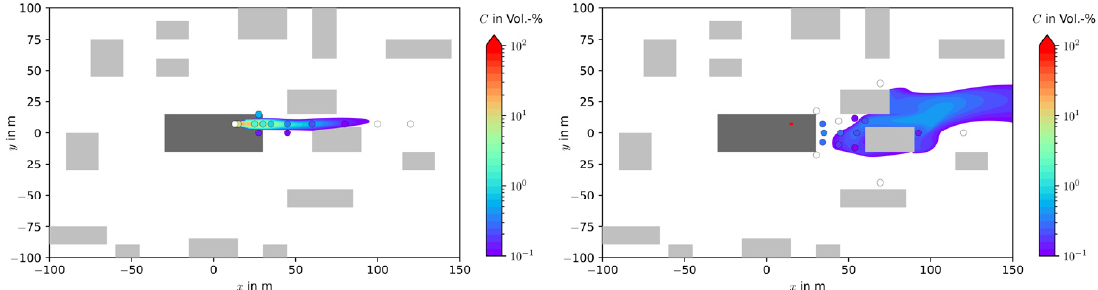
Figure 14. Heavy gas dispersion out of a roof top source (Case MR-M1-S4), left : concentration– isosurface in 16 m height over ground, right : concentration–isosurface in 2 m height over ground. Grey boxes representing buildings and the experimental measuring points represented by circles.